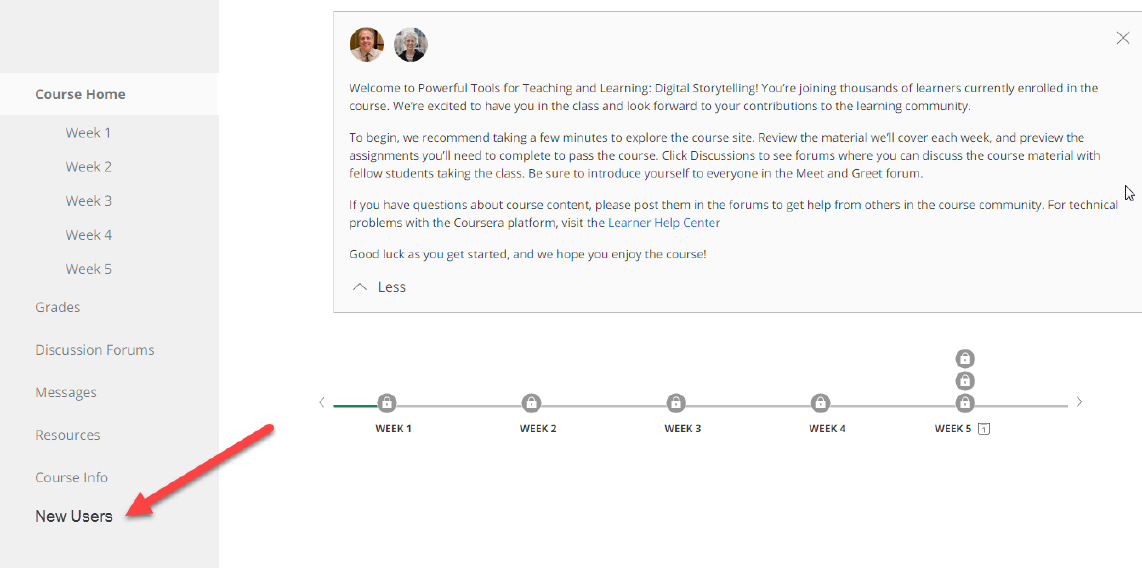
Figure 2. Adding a new users tab to help new students get adjusted to the